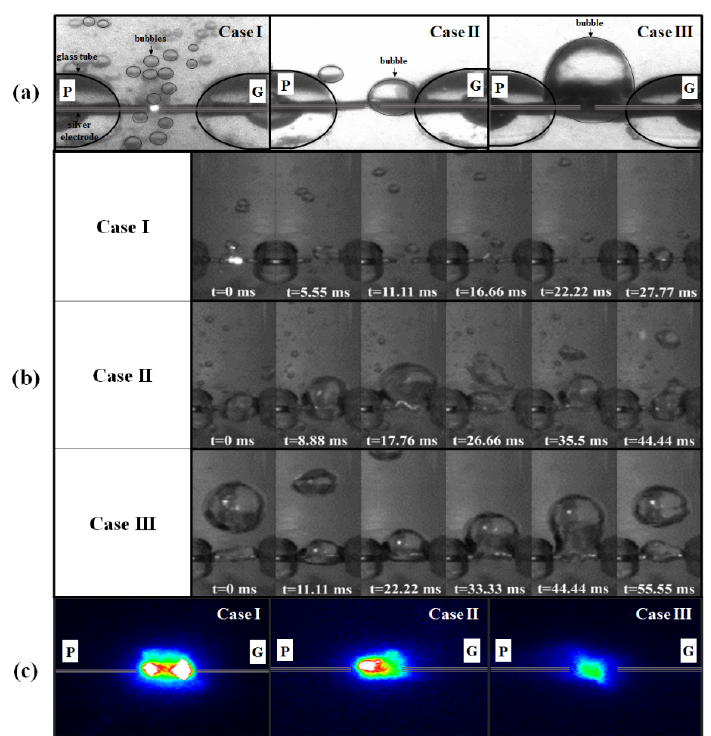
Figure 2. ( a ) Intensified charge ‐ coupled device (ICCD) images of bubbles; ( b ) detailed images of gas bubble formation times using high speed camera; and ( c ) ICCD plasma intensities during liquid plasma discharge when applying three different bipolar pulses in Figure 1 to powered electrodes (P), where G is grounded electrode.